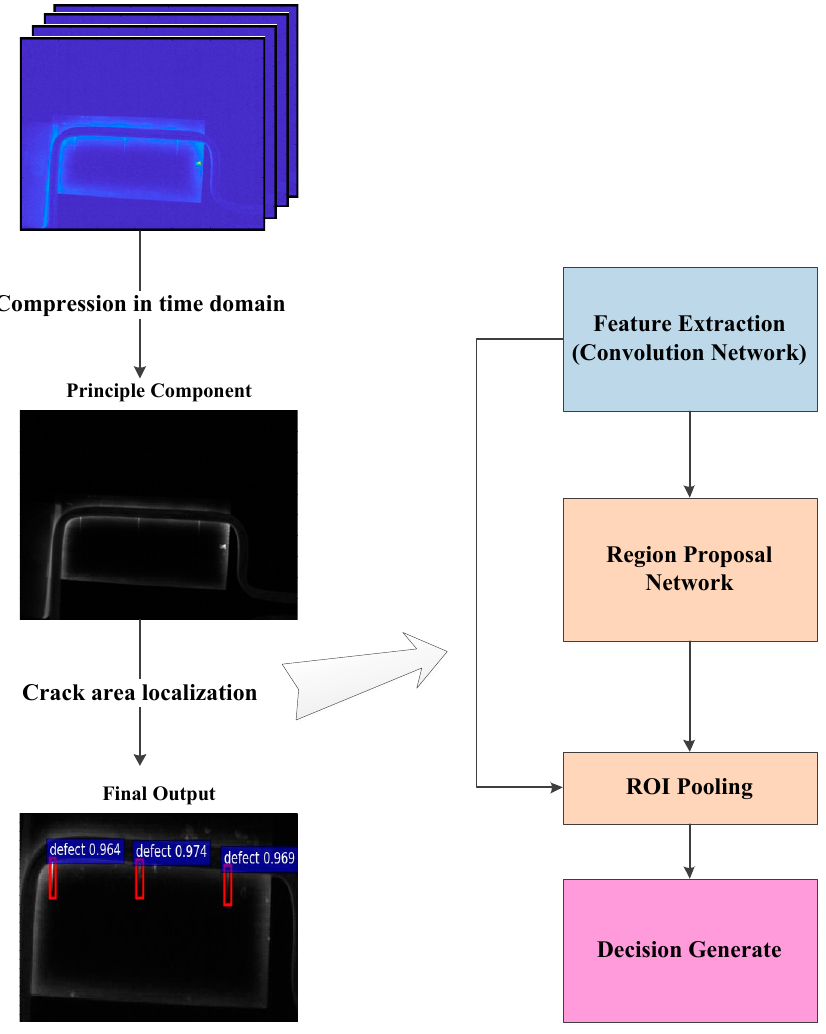
Figure 2. Proposed detection strategy.